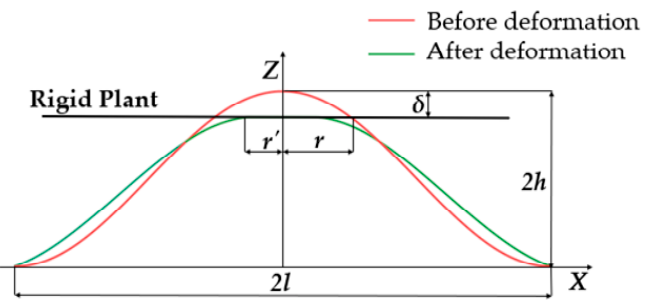
Figure 2. Two ‐ dimensional schematic of the contact deformation between a single axisymmetric cosinusoidal asperity and rigid plane. cosinusoidal asperity and rigid